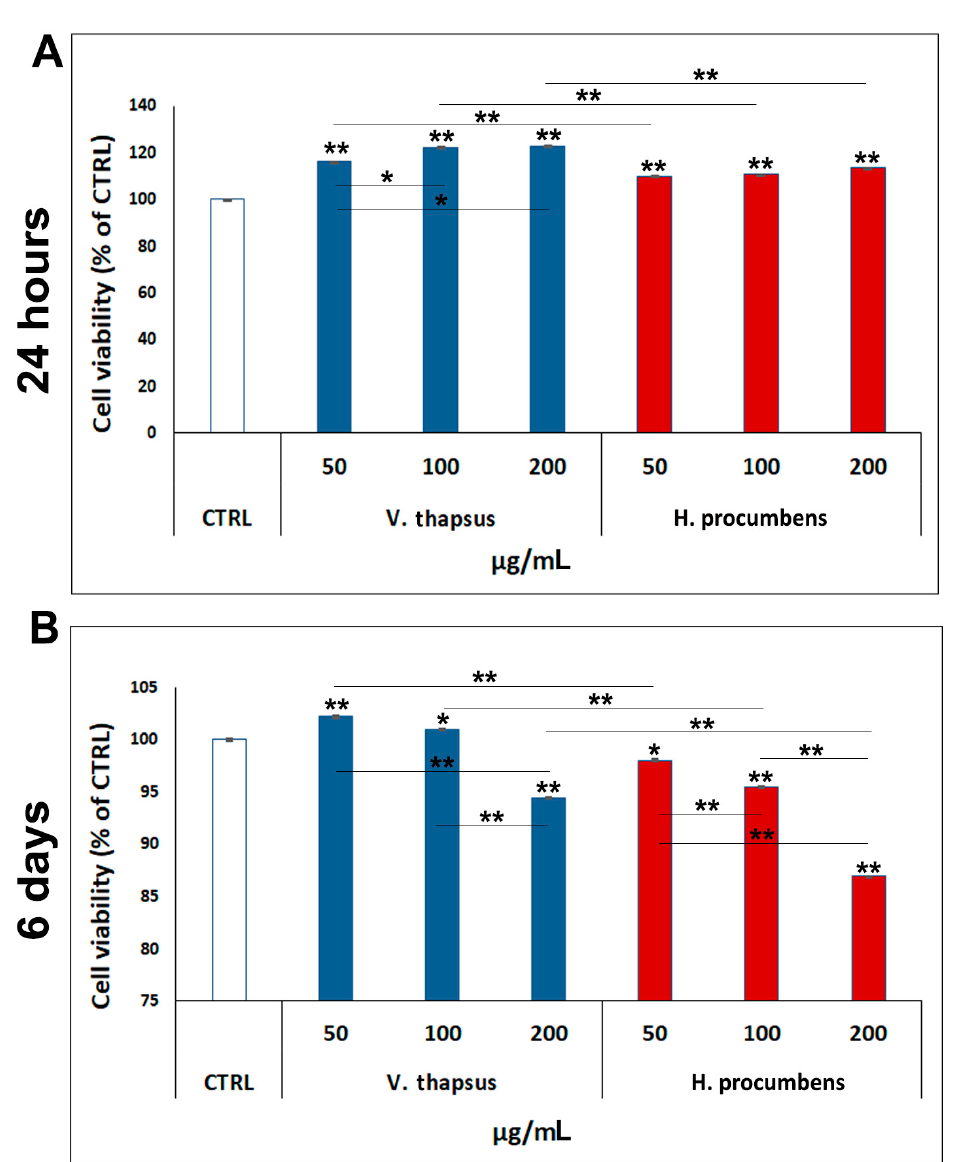
Figure 2. Cytotoxic effect of V. thapsus on RAW 264.7 cells. MTT test performed on RAW 264.7 cells treated with V. thapsus and H. procumbens extracts (50, 100 and 200 µg/mL) for 24 h and 6 days. H. procumbens = positive control. Data are represented as the means ± SD of three independent experiments. ANOVA test p -values were reported and (** p < 0.01 and * p < 0.05) indicate significant differences between the two groups, as reported by the Holm post-hoc test.